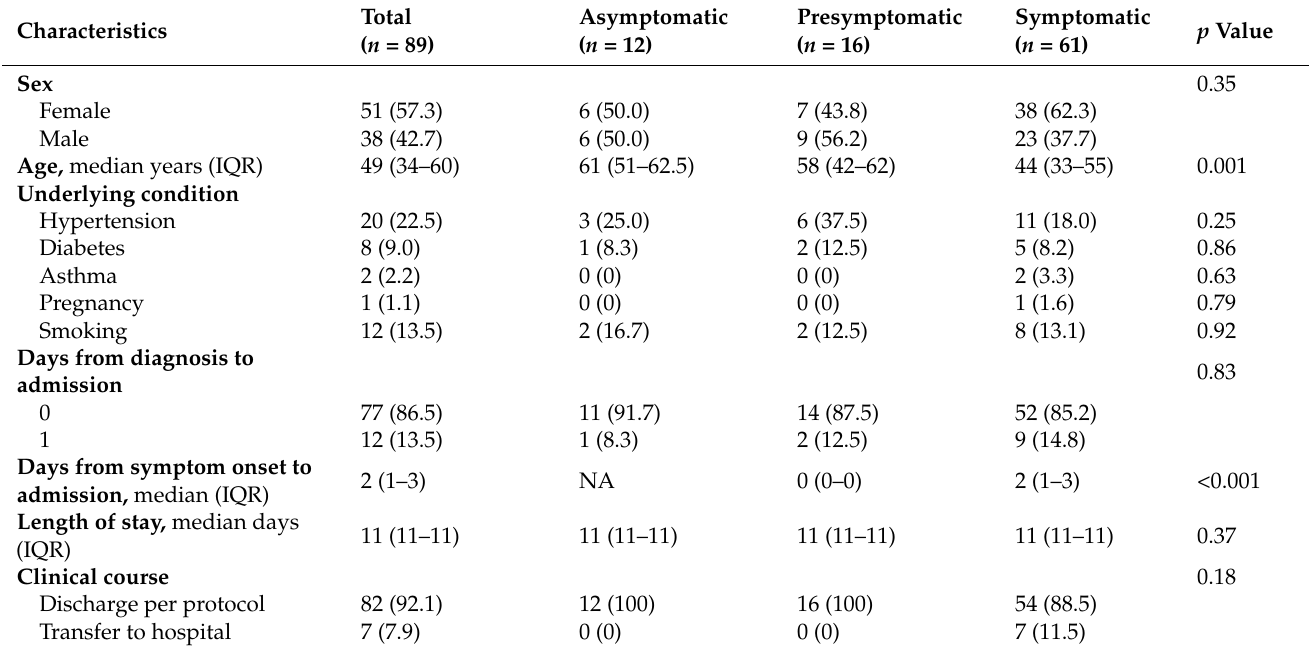
Table 1. Baseline characteristics of patients with asymptomatic or mild